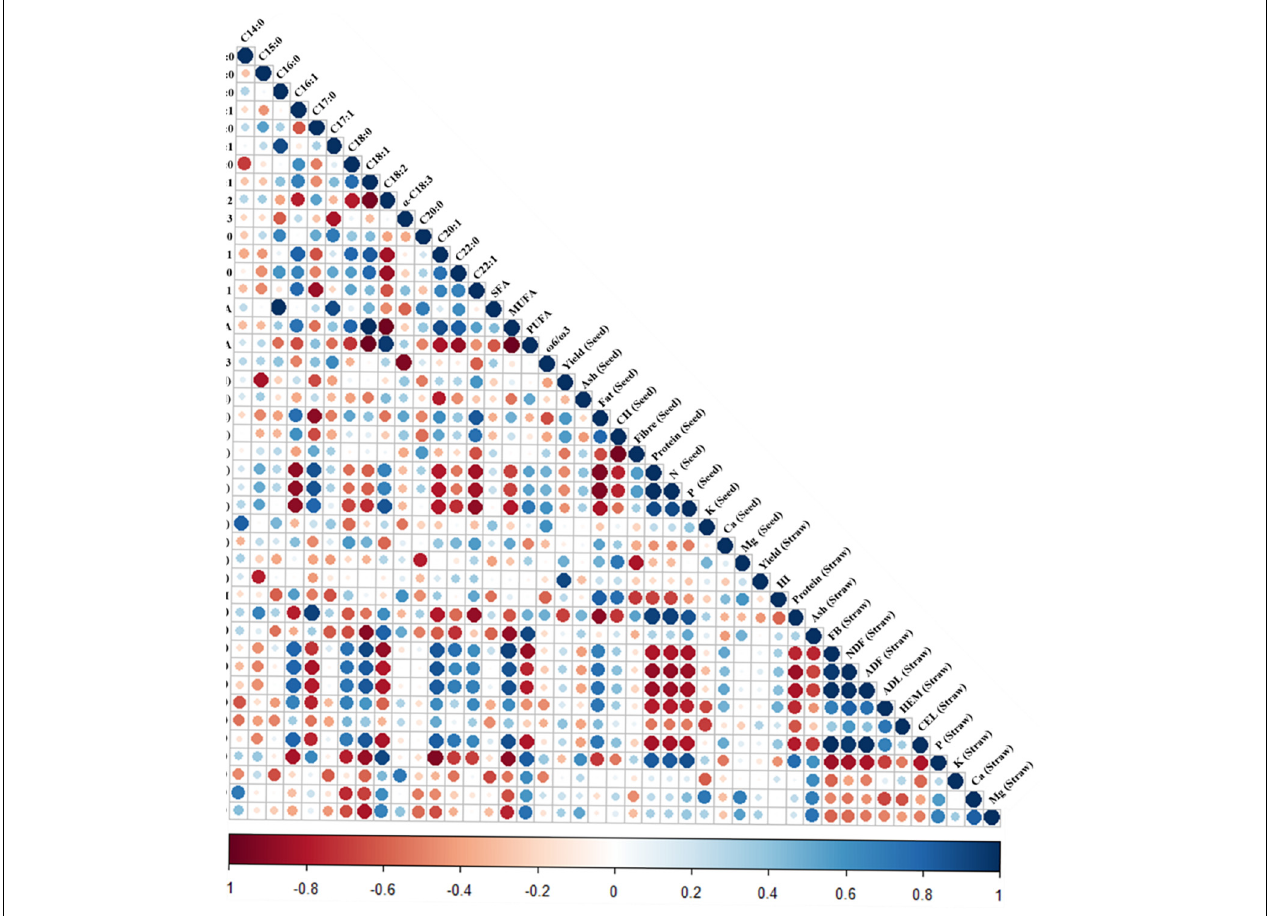
FIGURE 8 | Correlogram of variables measured. Pearson’s correlation coefficients ( r ) are given when the correlation between variables is statistically significant ( p < 0.05). Red cells indicate negative correlations, and blue cells show positive correlations. The variables considered in the correlogram were as follows: seed fatty acid contents (palmitic—C16:0, stearic—C18:0, oleic—C18:1, linoleic acid—C18:2, α -linolenic—C18:3, and erucic—C22:1), the PUFA, MUFAs, and SFAs, the ratio of omega-6 ( ω -6) to omega-3 ( ω -3) ( ω -6/ ω -3), seed yield, seed ash and oil, seed carbohydrates (CH), seed fiber, protein and N, P, K, Ca, and Mg contents, straw yield, harvest index (HI), straw protein, ash, and fiber contents (FB), straw neutral detergent fiber (NDF), acid detergent fiber (ADF), acid detergent lignin (ADL), hemicellulose (HEM), cellulose (CEL), and P, K, Ca, and Mg contents